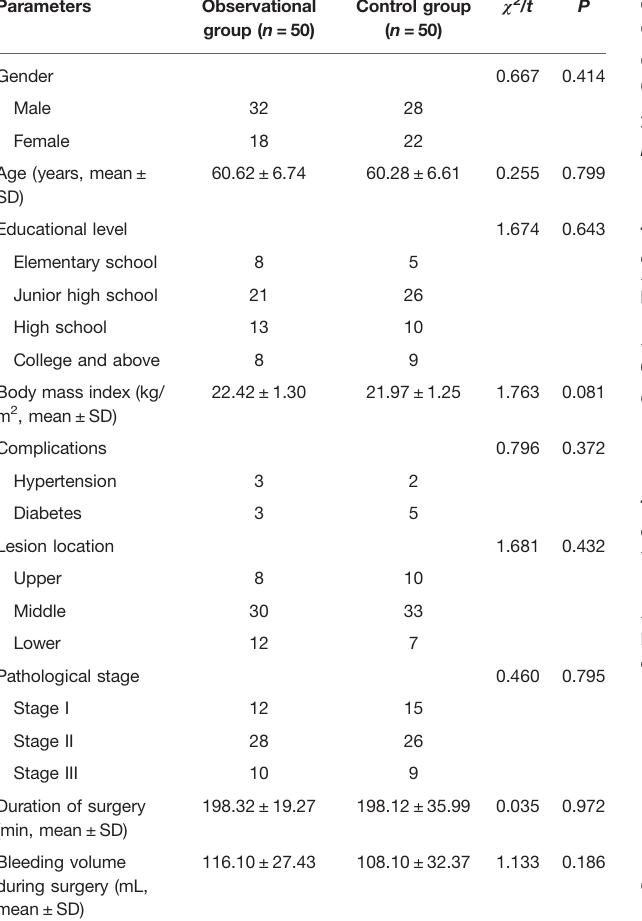
TABLE 2 | Baseline characteristics of patients in different groups.